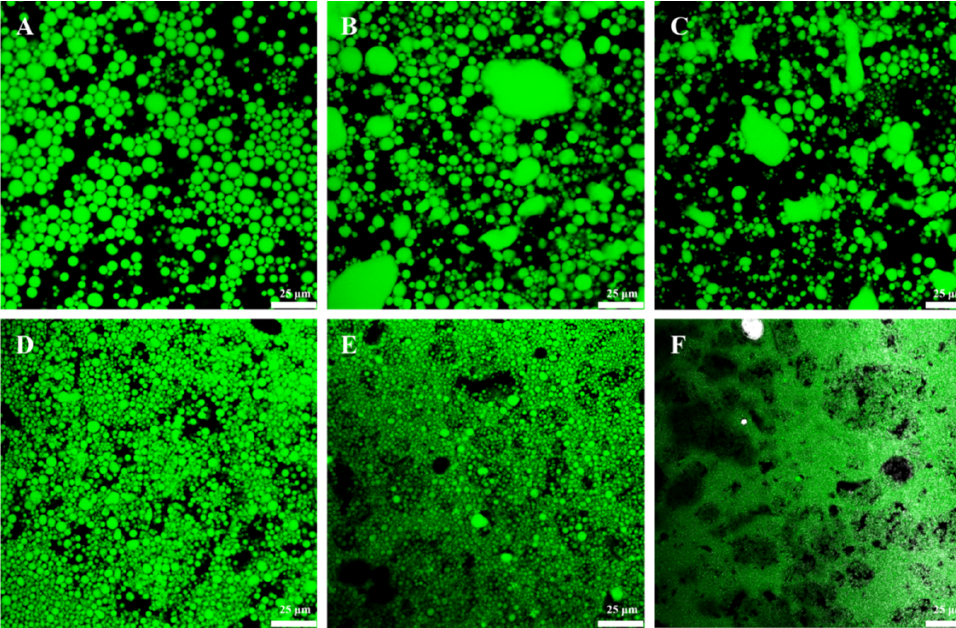
Figure 2. CLSM images of dual ‐ structured gel emulsions containing 50 wt% sunflower oil prepared by 4 wt% GA nanofibrils and different MG concentrations: ( A ) 0, ( B ) 1, ( C ) 2, ( D ) 4, ( E ) 8, and ( F ) 16 wt%. The gel emulsions were prepared using oil dyed with Nile Red and oil droplets are green in the images. All scale bars are 25 μ m.